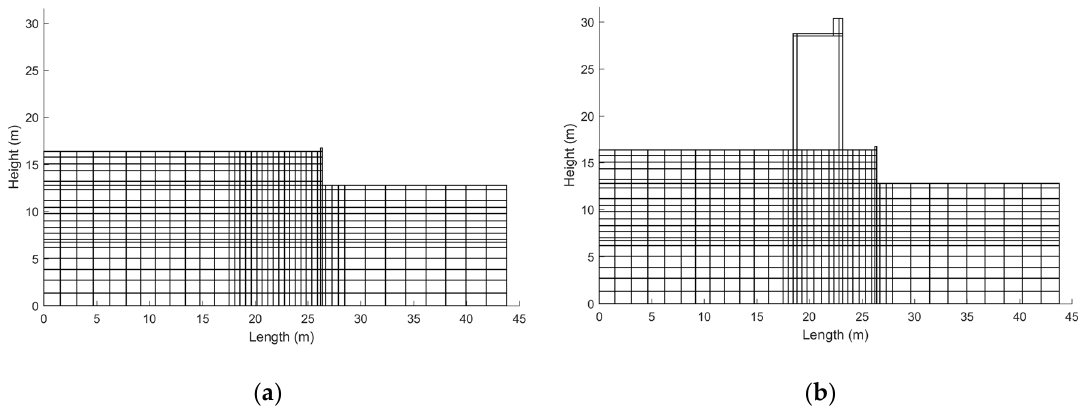
Figure 3. Finite element (FE) discretization: ( a ) a retaining wall only and ( b ) a retaining wall with an adjacent structure on the backfill.